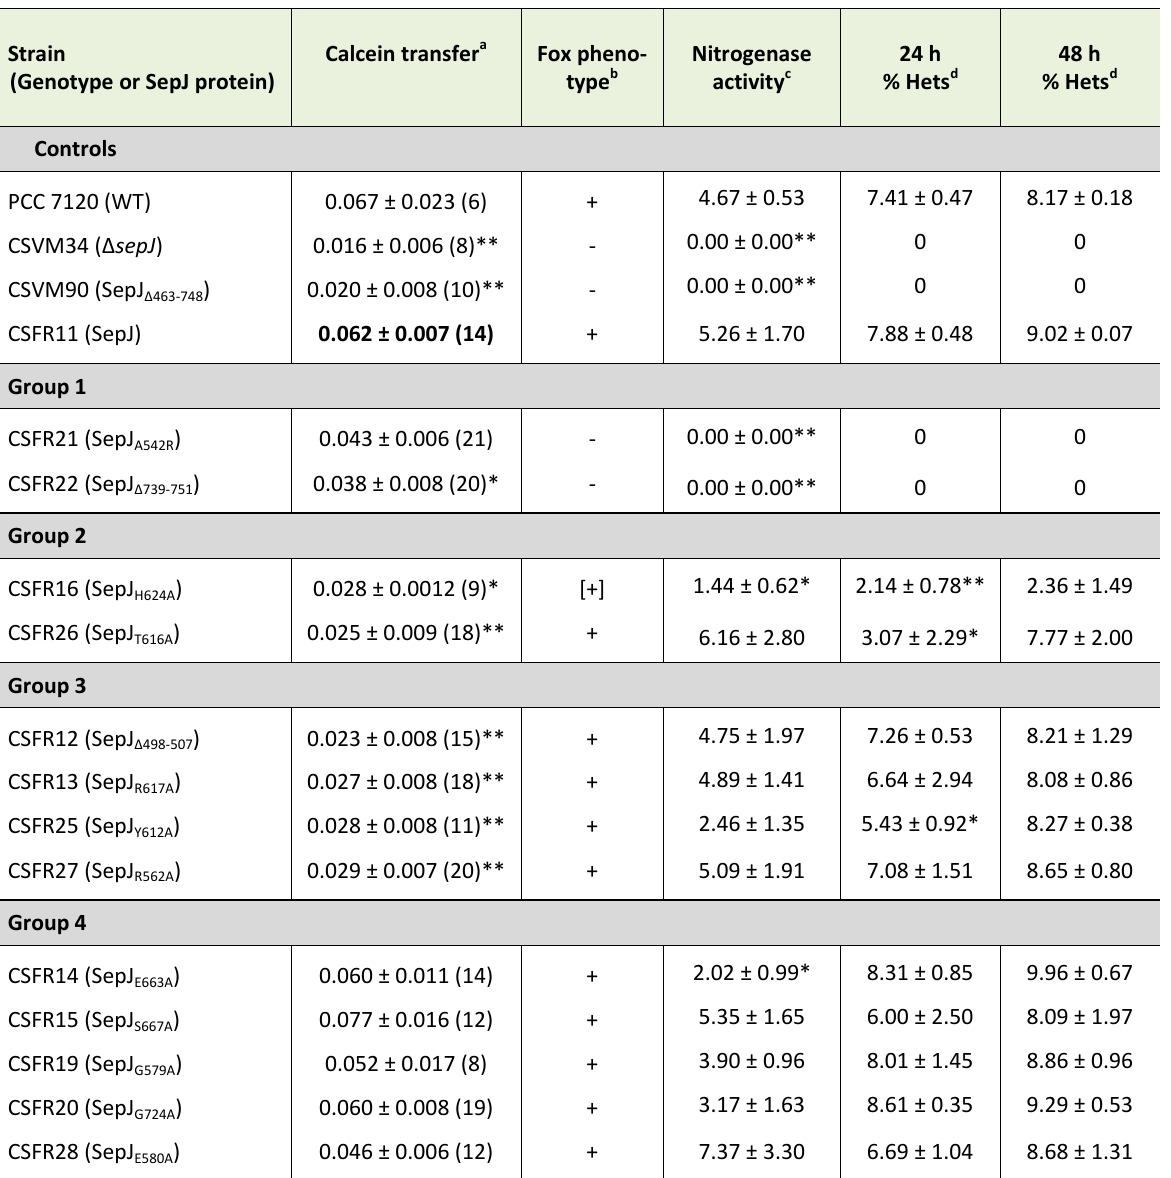
TABLE 1. Calcein transfer, Fox phenotype, nitrogenase activity and heterocysts in sepJ mutant strains.